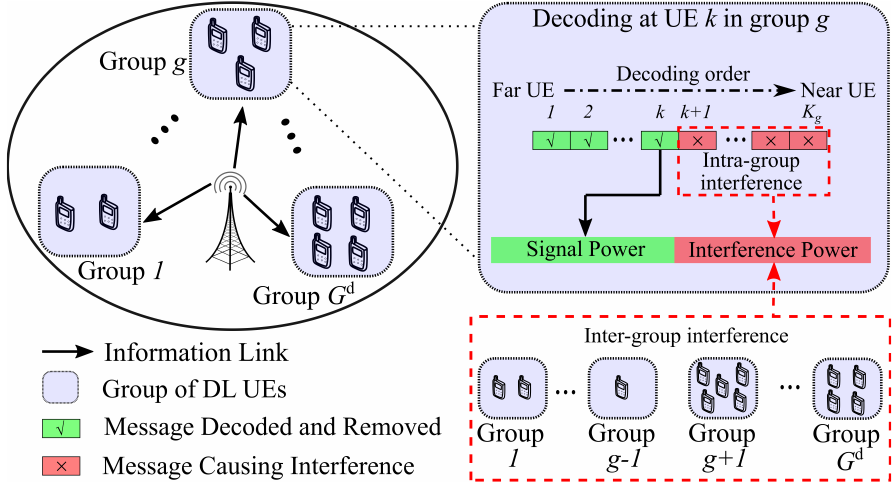
Figure 1. Illustration for successive interference cancellation (SIC) at the k -th UE in group g